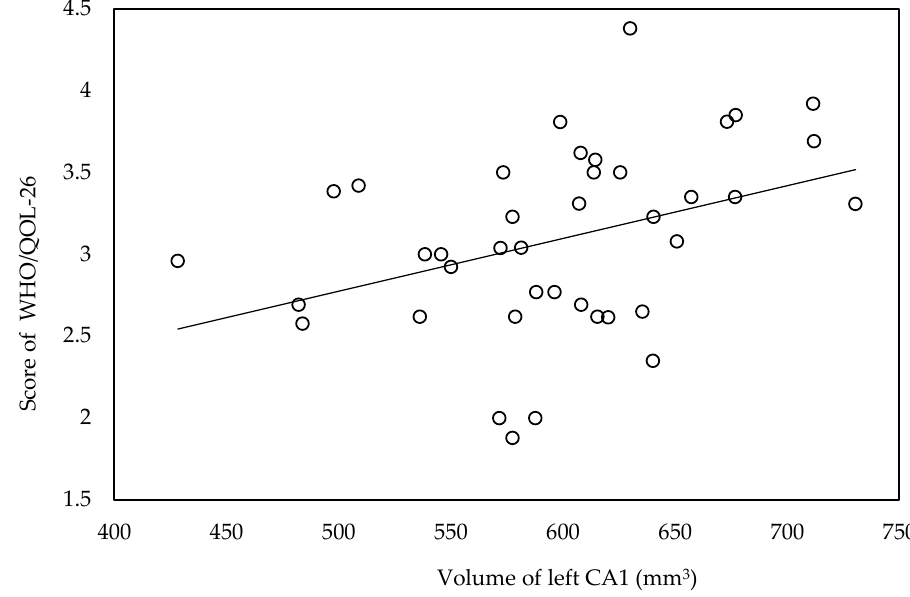
Figure 1. Scattergram for the association between KCL score and volume of whole hippocampus in the left ( a ) and right ( b ) hemispheres.